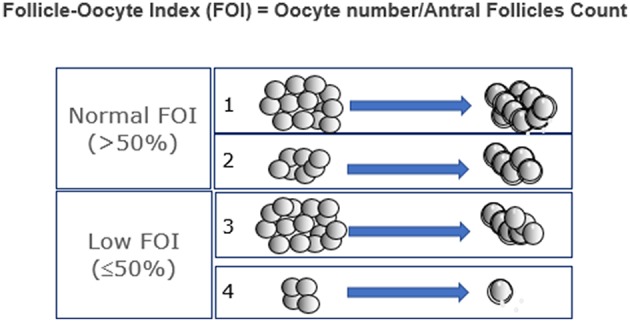
Ovarian resistance using the follicle-to-oocyte index (FOI). Reprint from Alviggi et al. (17).